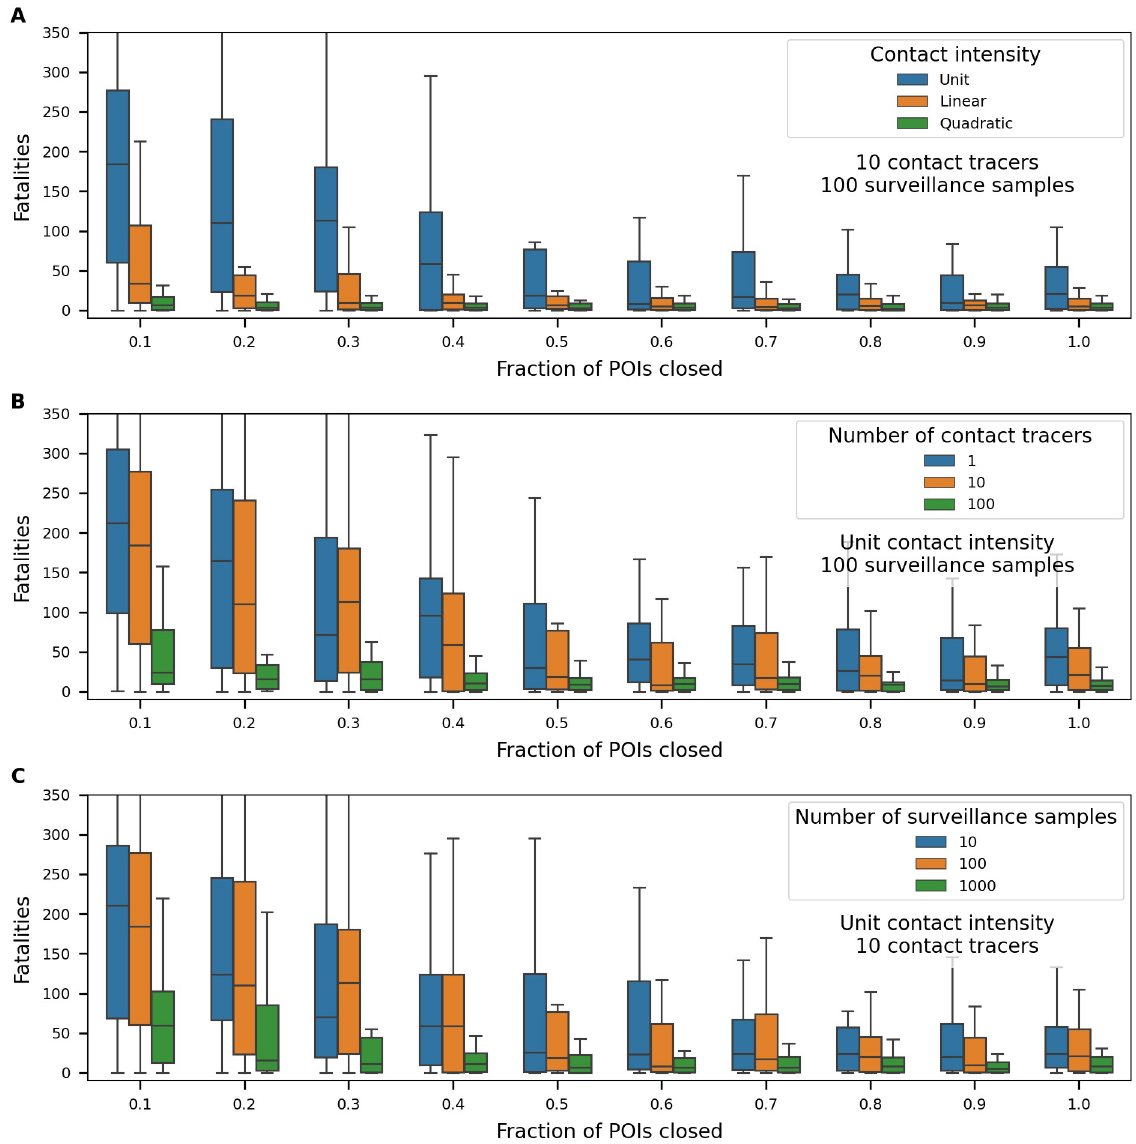
Fig 10. Epidemiological simulation results using the contact network. Impact of POI closure on fatalities in a one-year simulation of COVID-19 spread through 10,000 person contact networks. Subplots show the influence of A. contact intensity, B. number of contact tracers, and C. number of surveillance samples. Variables that are held constant in each subplot are noted below the